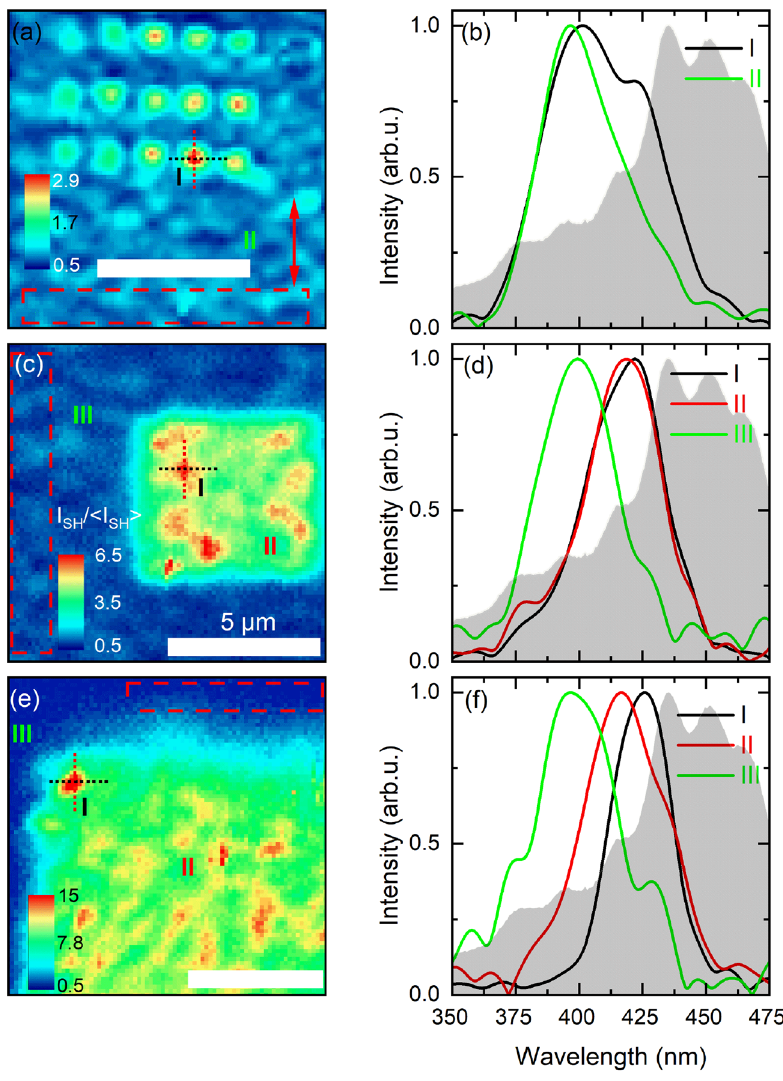
Figure 3: Second harmonic (SH) generation intensity maps (a, c, d) and prototypical spectra (b, d, f) of the three investigated structures: (a – b) a dimer of triangular holes, (c – d) a hexagonal hole array, and (e – f) a hexagonal hole array with defects. Left: in each image, the SH emission intensities are normalized to the average SH from the neighboring silver film, taken from the area marked by the red-dashed box. The black- and red-dotted cross indicates the most intense hot spot in each structure. The po- larization of the incident light is along the y -axis for all measurements as indicated by the red arrow in (a). The scale bar of all im- ages is 5 µm. All experiments are performed by exciting with 6-fs laser pulses centered at 880 nm. Right: normalized SH spectra from exemplary positions inside and outside the nanostructured arrays. The grey background shows the frequency-doubled spectrum of the Ti:Sapphire